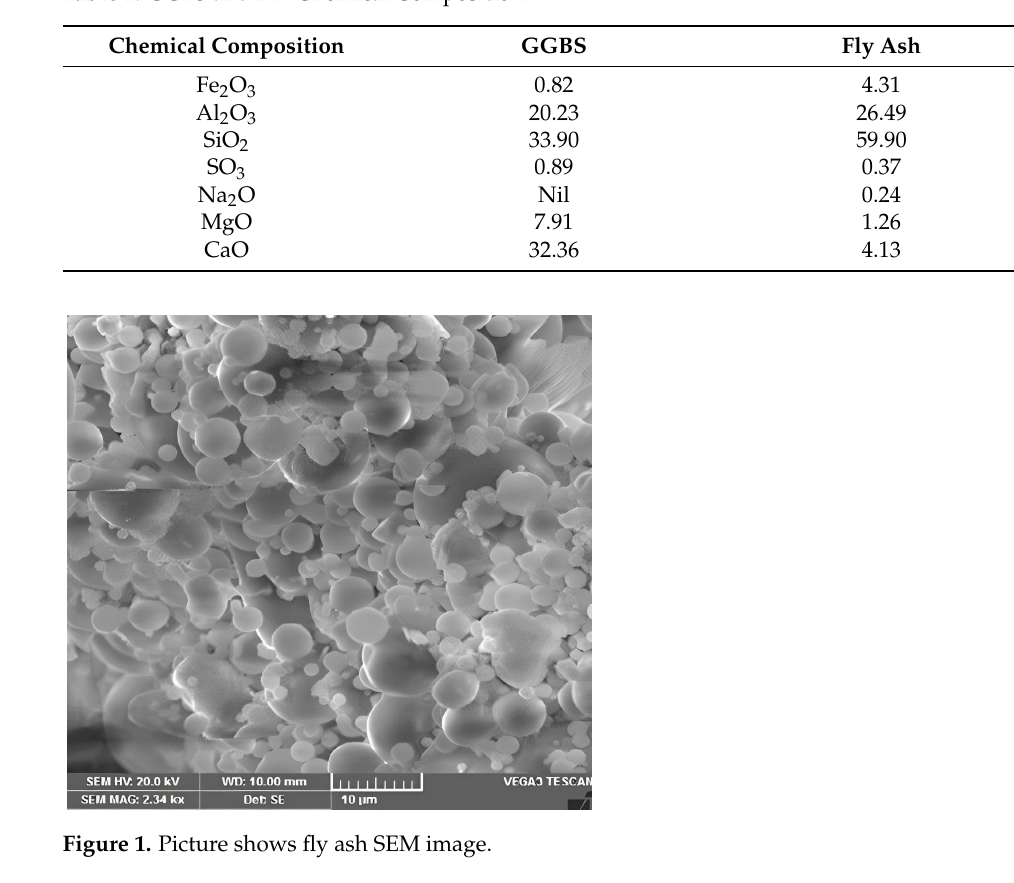
Table 1. GGBS and FA: Chemical Composition.